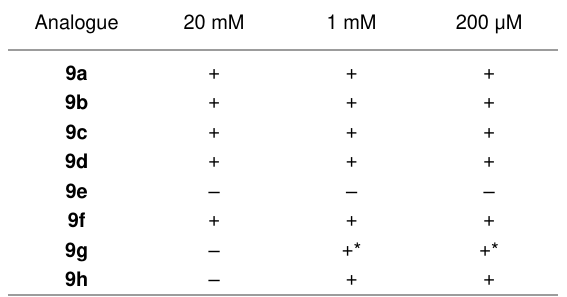
Table 1: Halos of hemolysis or inhibition of hemolysis of S. aureus ATCC 25923 on sheep blood agar plates (Assay 2). a Analogue